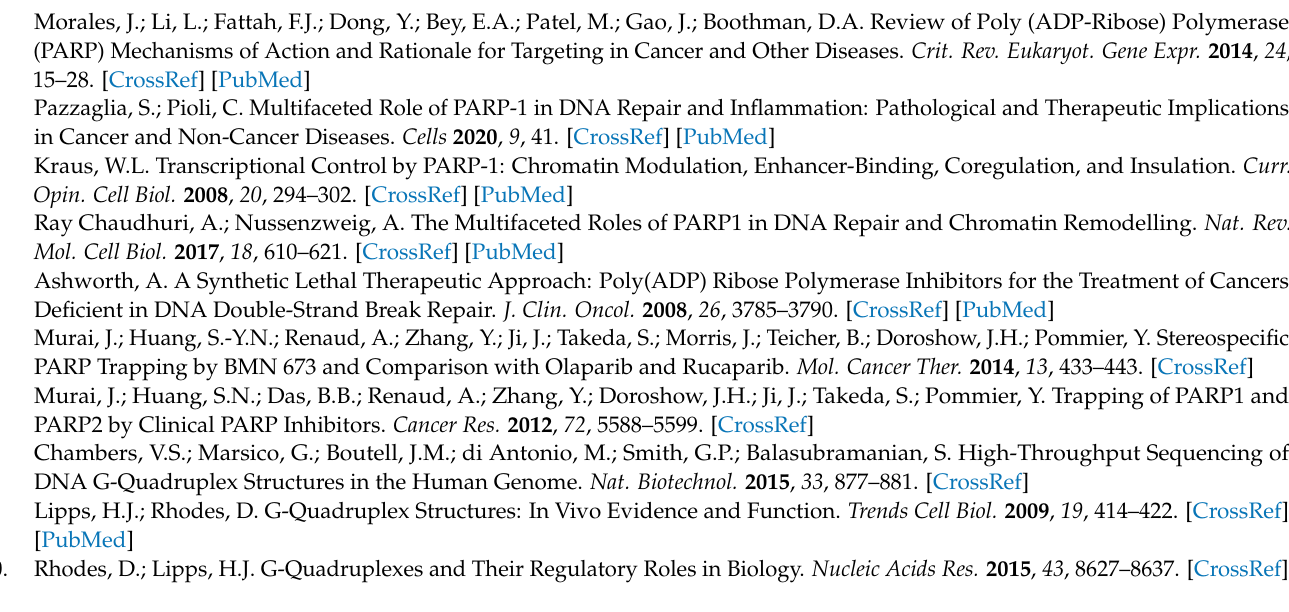
Figure S2: Complete set of CD spectra recorded along the melting of TP3-T6 (a) and of the TP3- T6:curaxin (1:3) mixture (b); Figure S3: Results of the analysis by means of MCR-ALS of the complete set of CD spectra recorded along the melting of TP3-T6; Figure S4: CD spectra measured along the titration of TP3-T6 with BA41. Figure S5: Melting experiments with BMH-21 and BA41; Figure S6: CD-monitored titration with